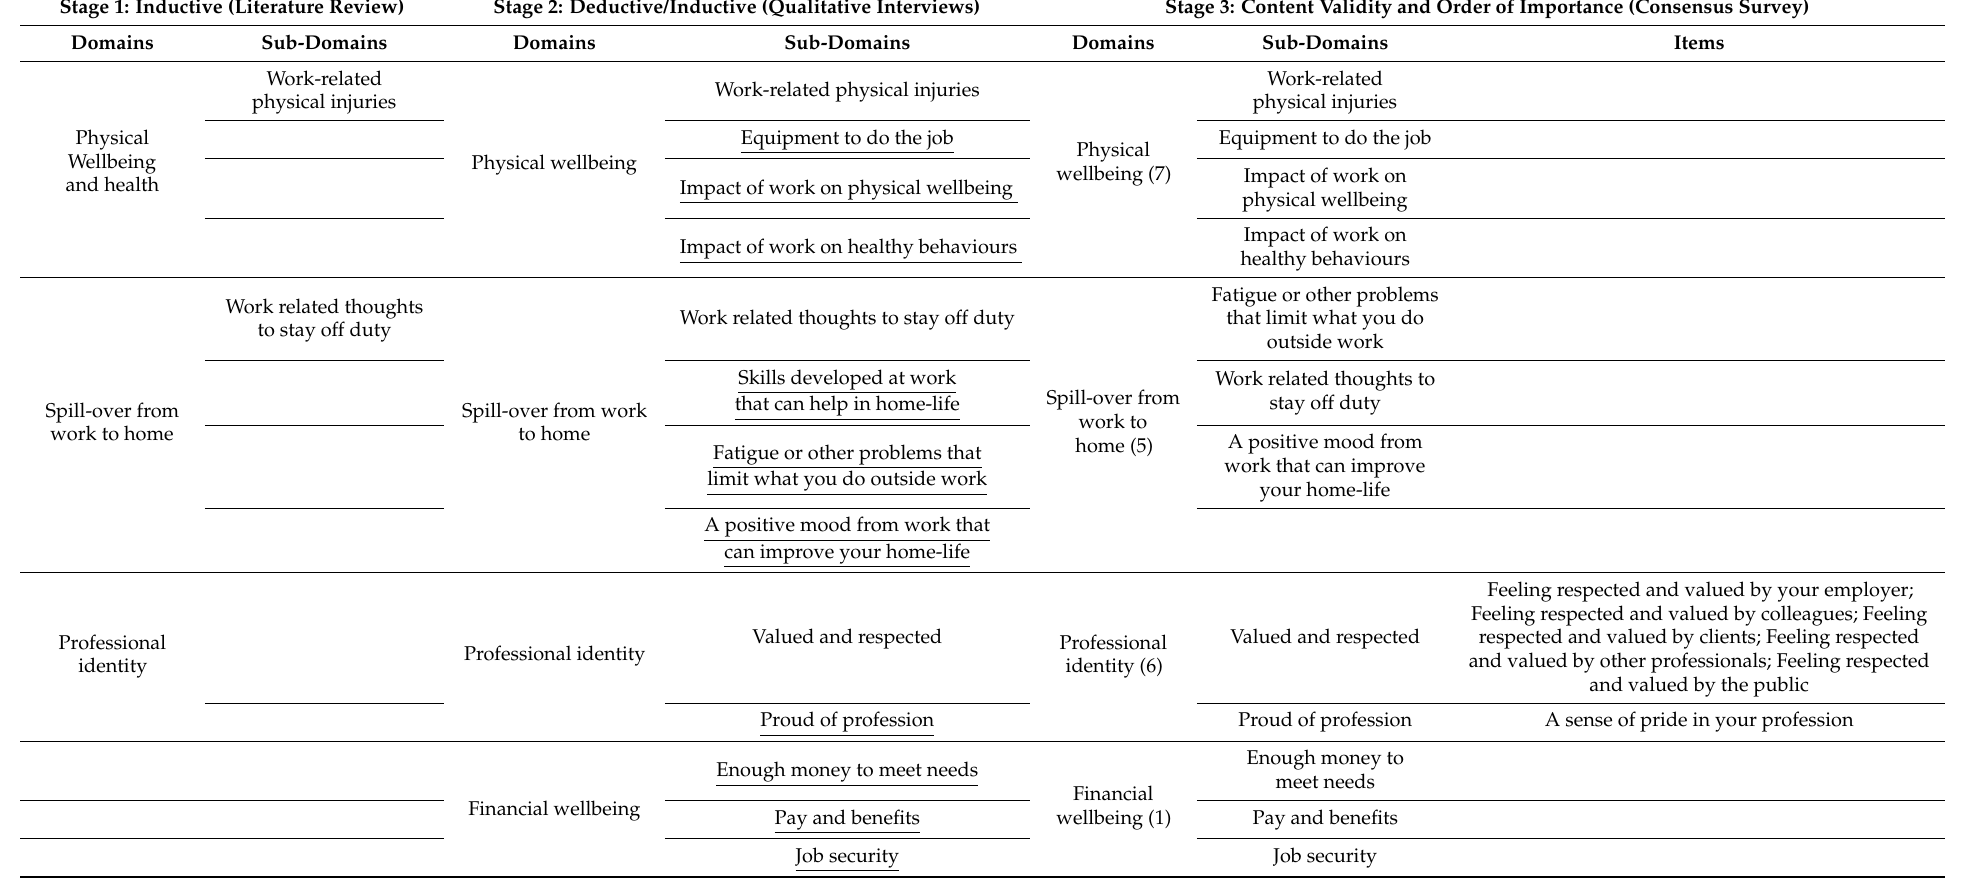
Stage 3: Content Validity and Order of Importance (Consensus